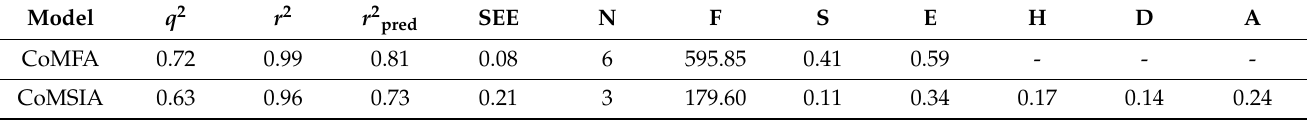
Table 6. Final CoMFA and CoMSIA models derived by applying different StDev*Coeff and grid spacing values.